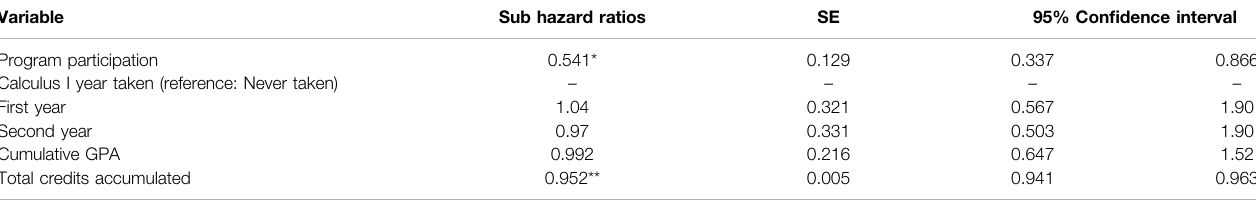
TABLE 7 | Competing-Risks Analysis: Program Participation. By Dina Ghazzawi, Donna Pattison, and Catherine Horn. Variable Sub hazard ratios SE Program